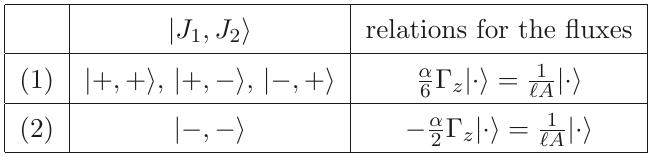
Table 5 . Decomposition of (3.68) KSE into